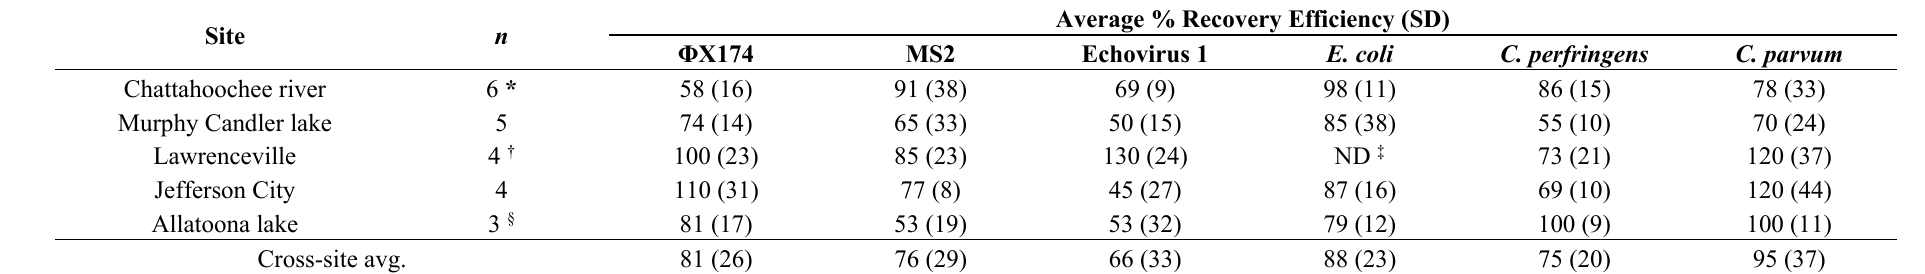
Table 2. Ultrafiltration (UF) recovery efficiencies for study